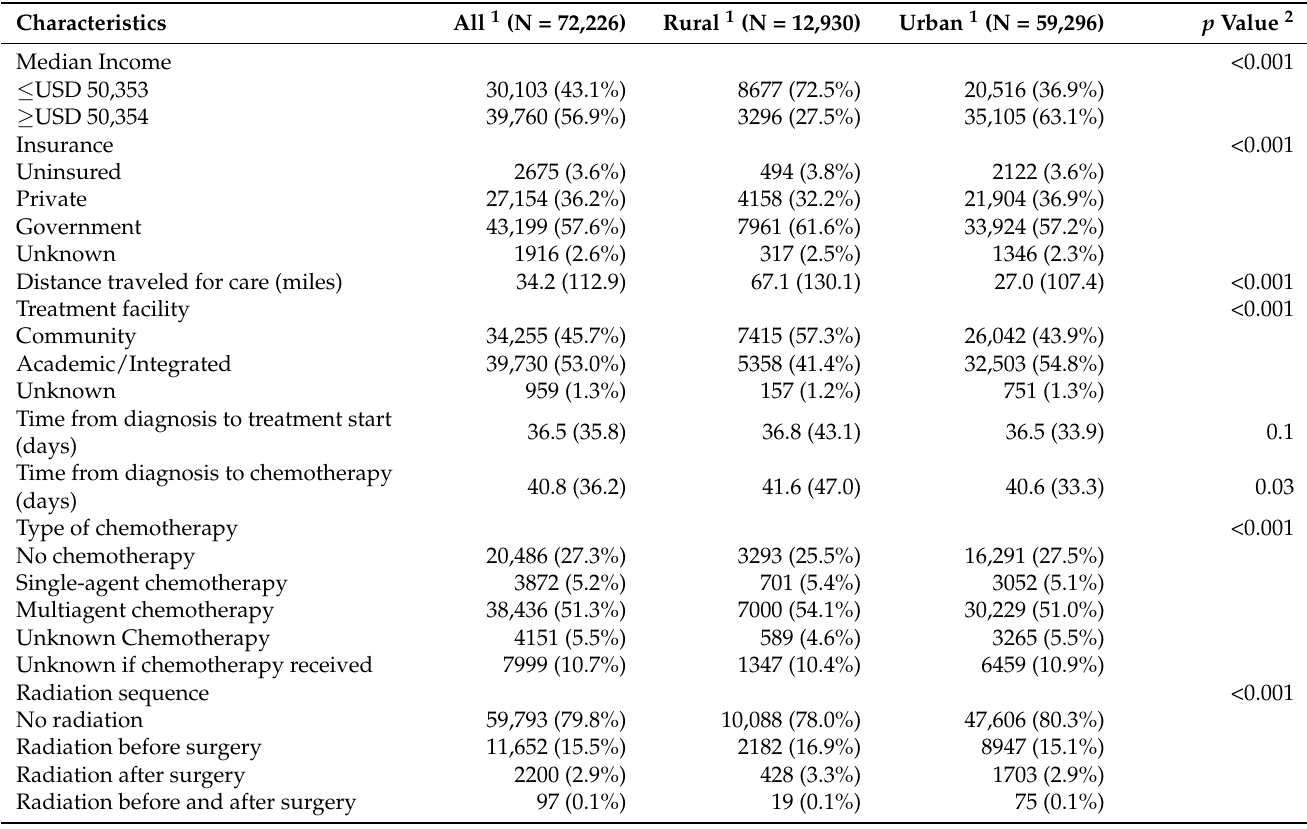
Table 4. Descriptive characteristics of the quality-of-care variables in the NCDB